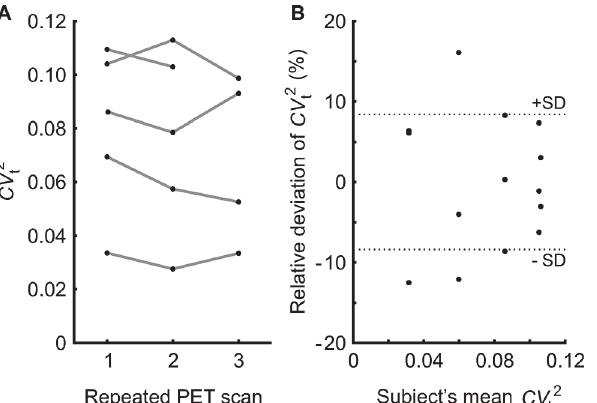
Fig 4. Evaluation of the reproducibility of the estimation method using multiple PET scans of pulmonary perfusion in five subjects to estimate noise-free perfusion heterogeneity ( CV t2 ). A: Estimated CV t2 showing the intra-subject variability (connected data points) and the inter-subject differences. B: Relative deviation of CV t2 from each subject ’ s mean vs. the subject ’ s mean CV t2 of repeated PET scans shows the normalized intra-subject variation among repeated scans that was used to characterize reproducibility. The standard deviation (SD) was